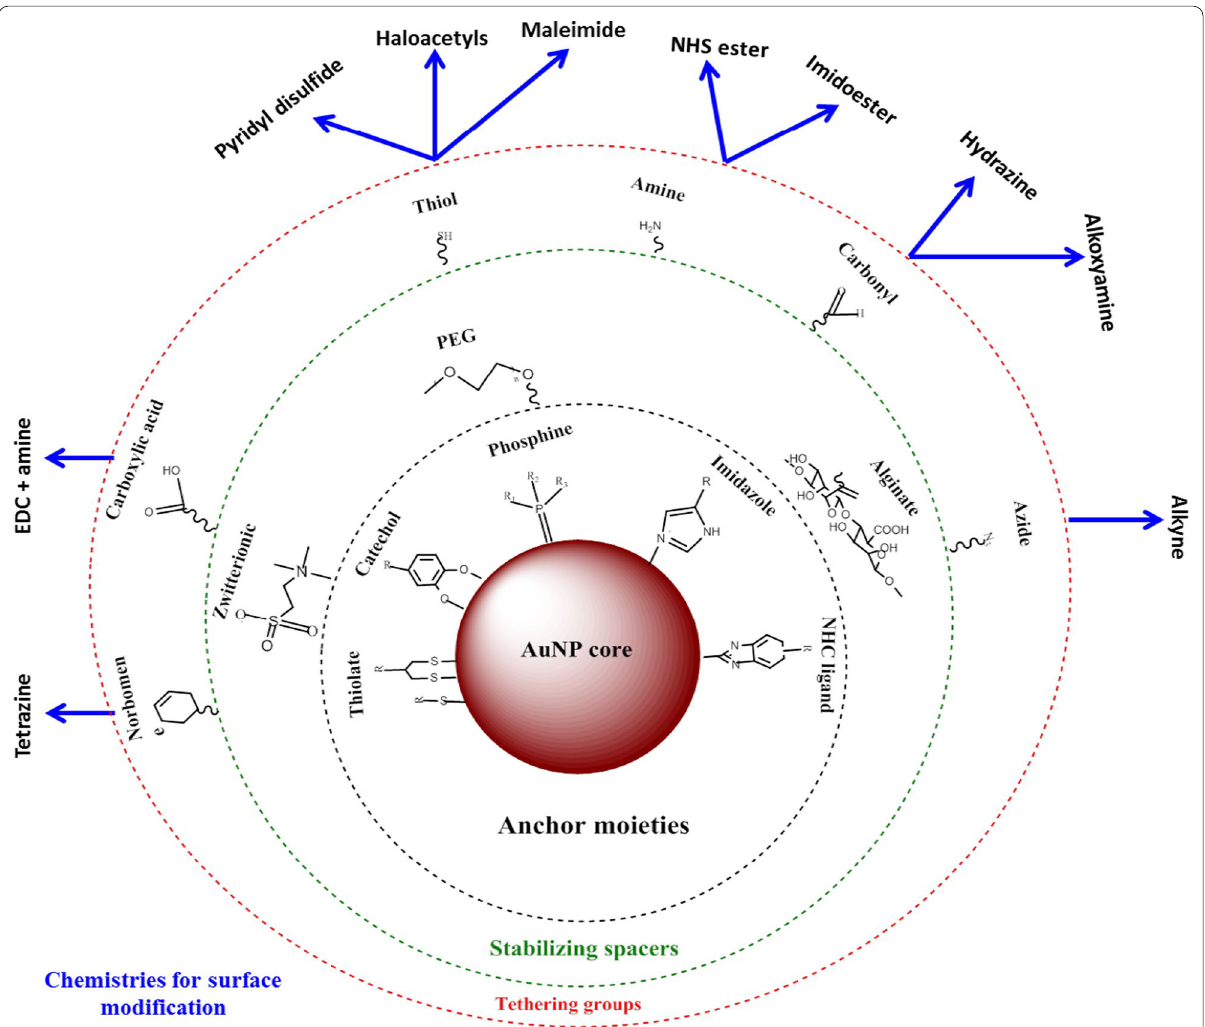
Fig. 2 Synthesis and functionalization of AuNPs. Biomolecules with functional groups are first adsorbed on the NP surface through gold-thiol affinity. Then, other functional groups such as amine group can be used to bind molecules with a carboxyl groups to attach targeting or drug moieties. Adapted from